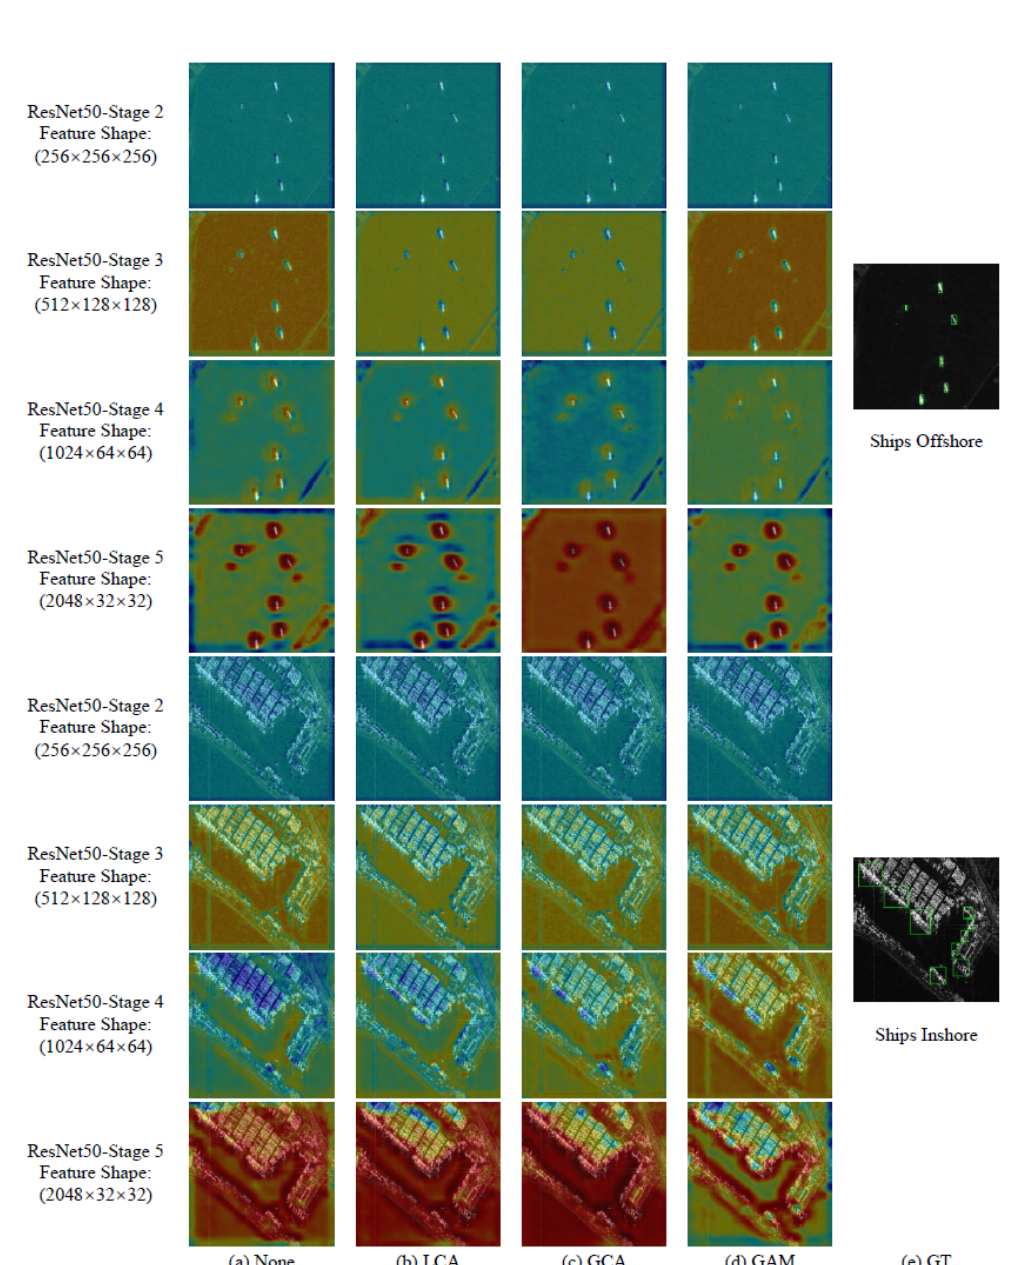
Figure 6. Global attention module (GAM) visualization results for the ships offshore and inshore, respectively. We compared the visualization results of GAM with the baseline ResNet50 and Local Context Attention (LCA) and Global Context Attention (GCA) modules in GAM, respectively. The GAM visualization was calculated for the convolutional outputs from stage 2 to stage 5 in ResNet50 with the feature map in different resolutions, which are used to construct the feature pyramid. The ground-truth (GT) is shown on the right of each input